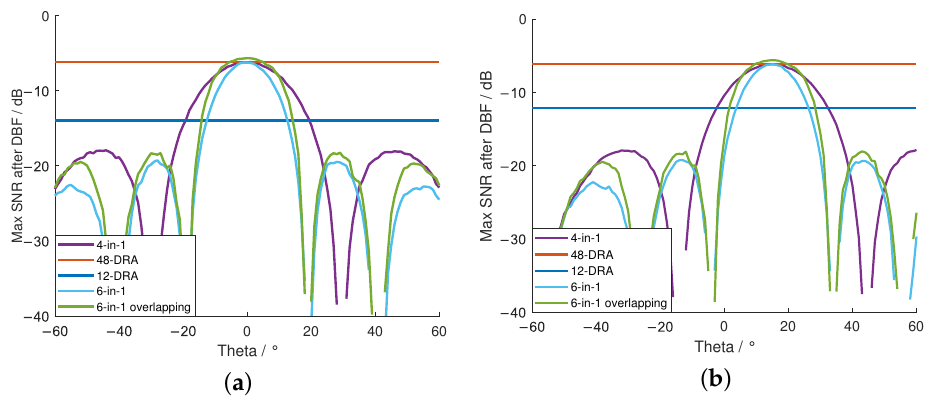
Figure 10. The spatial sensitivity of subarray structure with input SNR = − 20 dB. ( a ) Without phase shifter. ( b ) With phase shifter and pointing at 15 ◦